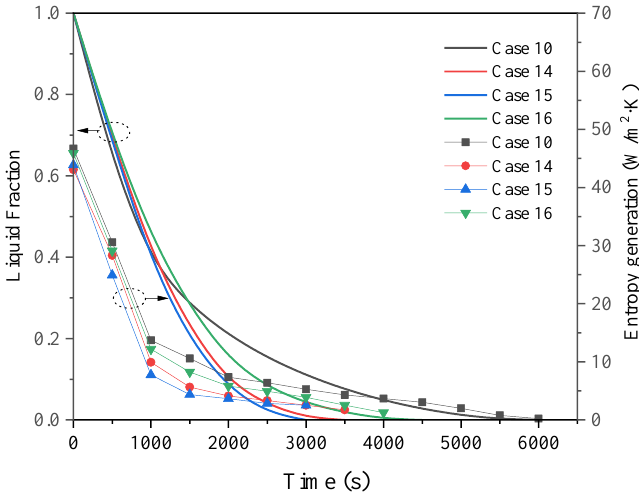
Figure 23. Liquid fractions and entropy generation for Cases 10, 14 – 16.